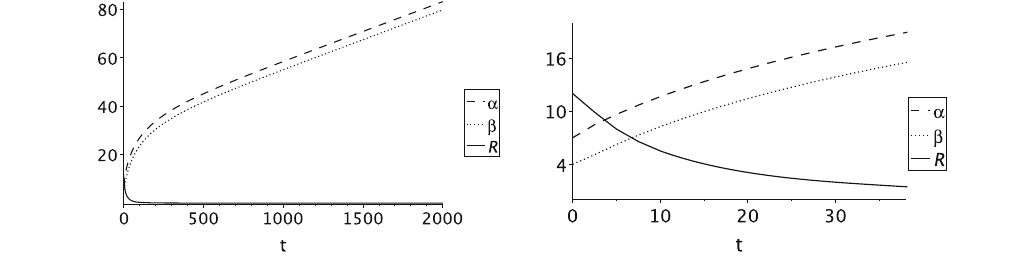
Fig. 1 Numerical solution to the system of equations (8), (9) and (10) for initial conditions α( 0 ) = 7 , β( 0 ) = 4 , ˙ α( 0 ) = 1 , ˙ β( 0 ) = 0 , ˙ R ( 0 ) = 0. The initial condition R ( 0 ) (cid:4)